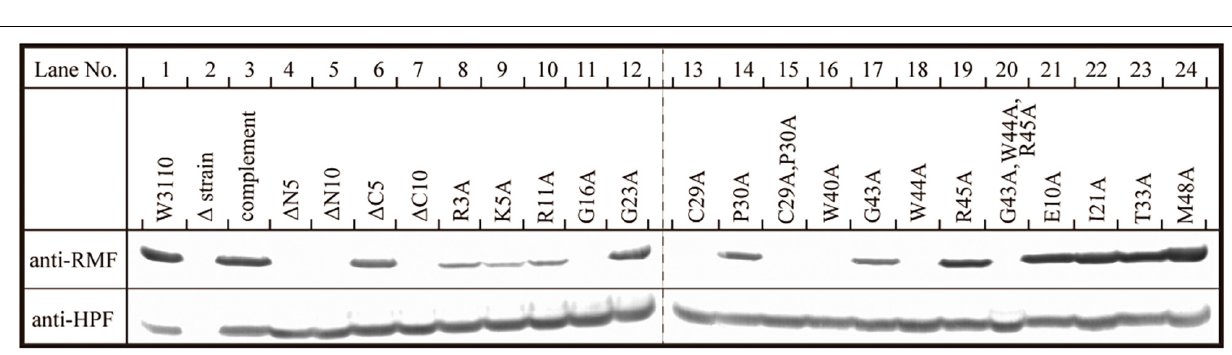
FIGURE 4 | Formation of 100S ribosomes after expression of RMF with mutations involving incompletely conserved amino acids. The experimental procedures are the same as those of Figure 3 . (A–C) Represent strains expressing RMF in which incompletely conserved amino acids were changed to alanine. (D–F) Represent strains expressing RMF deleted for incompletely conserved amino acids. The double-headed arrows in (A–C) indicate the fractionated regions that were analyzed by western blot (see Figure 5 ).